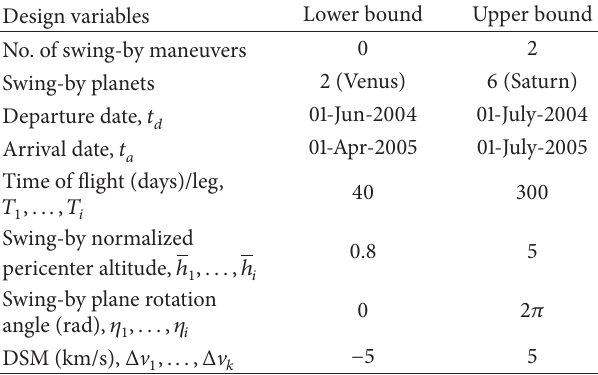
Table 6: Bounds on design variables for JEO mission—Zero-DSM model.